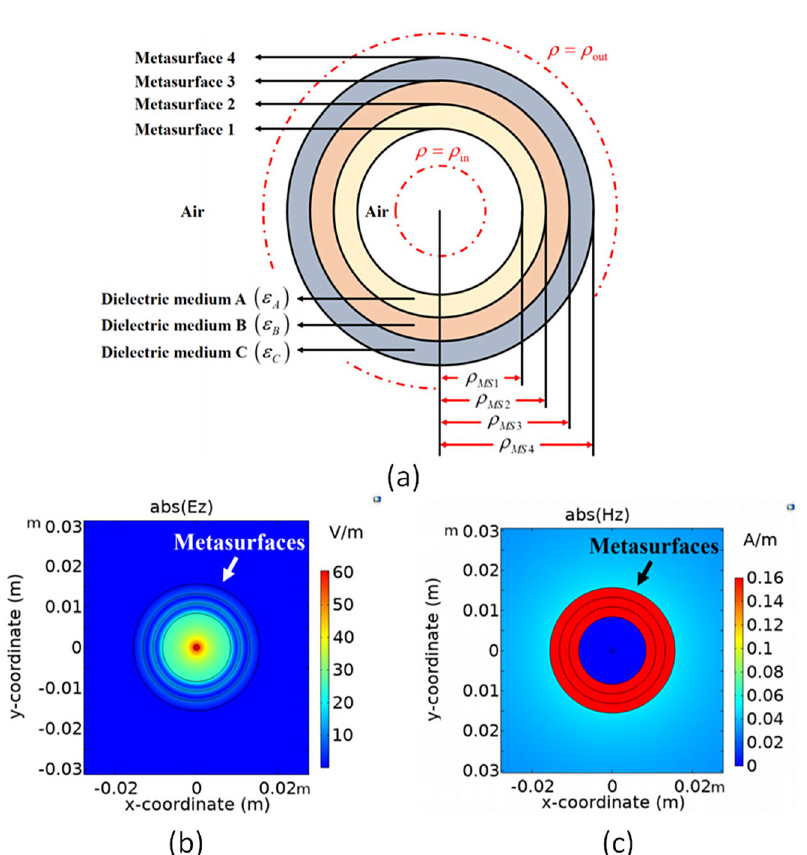
Figure 25: (Reprinted with permission from Ref. [114]). A compound metaoptic reshapes an incident Gaussian beam to produce a Dolph – Chebyshev far- fi eld pattern pointed toward 40 ° . The metaoptic performance is shown in (a) as the trans- mitted electric fi eld amplitude λ = 3 from the metaoptic, (b) as the far- fi eld radiation pattern, and (c) as the real part of the simulated electric fi